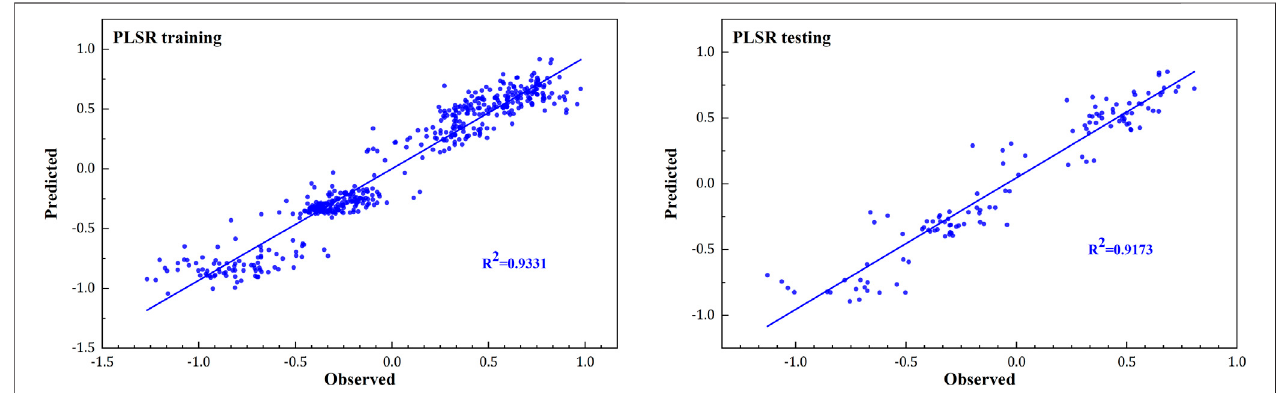
FIGURE 4 | Training (left) and testing (right) accuracy of special skills assessment results of observed and predicted from the PLSR model in the female runners.